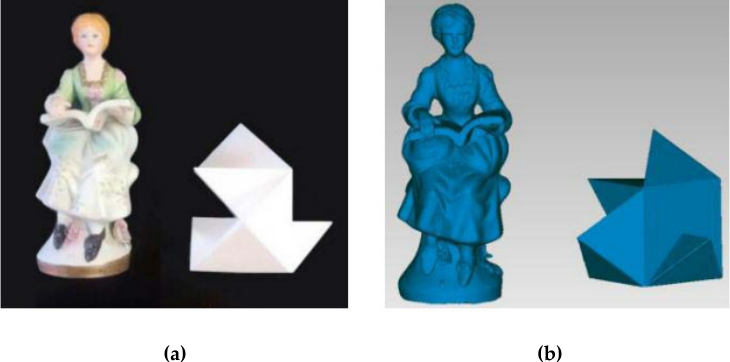
Figure 14. ( a ) The test objects for multiple-view reconstruction: a freeform statue and a 3D tangram; ( b ) reference 3D models for multiple-view reconstruction, obtained starting from the Romer Absolute Arm acquisition (an accuracy of ± 0.063 mm).